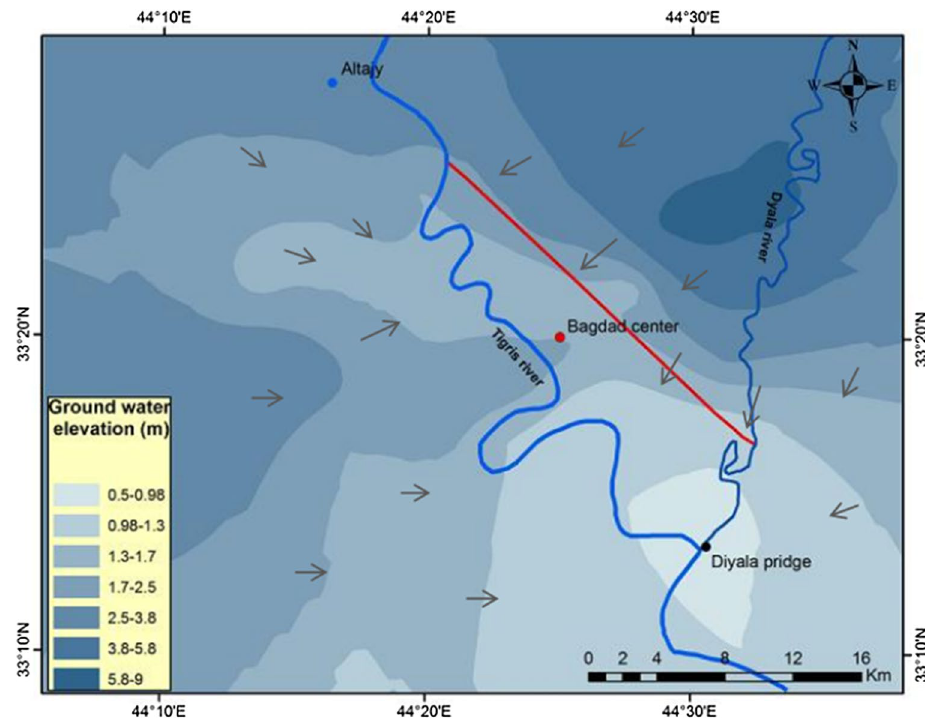
Fig. 4 Groundwater flow map of the study area